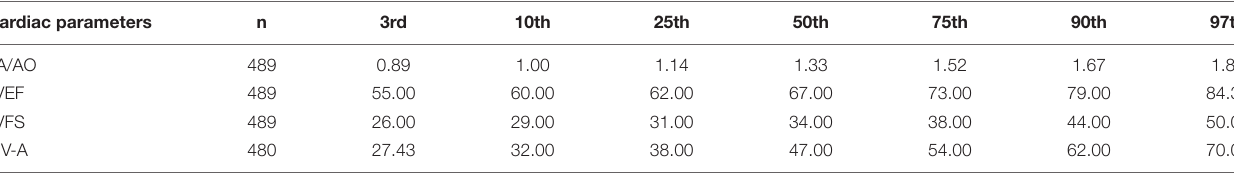
TABLE 12 | Percentiles of four cardiac parameters within seven days of 489 preterm infants. Cardiac parameters